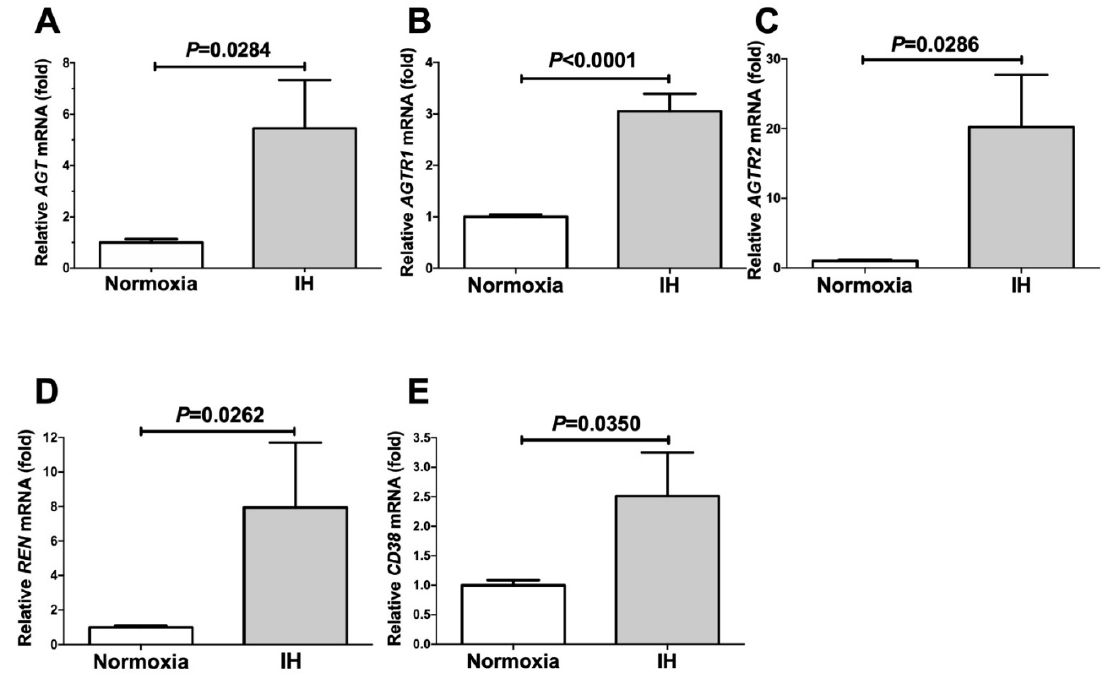
Figure 1. The mRNA levels of AGT ( A ), AGTR1 ( B ), AGTR2 ( C ), REN ( D ), and CD38 ( E ) in the HEK293 cells subjected to normoxia or IH for 24 h. The levels of the RAS mRNAs were measured by means of a real-time RT-PCR using β -actin as an endogenous control. The data are expressed as the mean ± SE for each group of six independent experiments (n = 6). The statistical analyses were performed using a Student’s t -test.